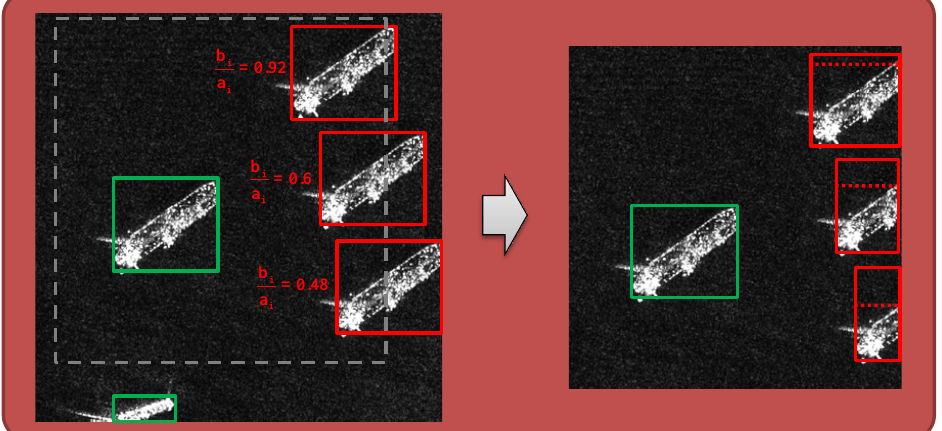
Figure 6. Bounding box error of different targets.